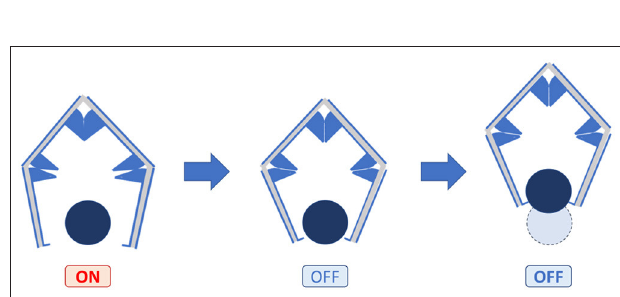
FIGURE 15 | Concept of self-folded gripper. The left and right joints open when a voltage is applied, and close when the voltage is removed.